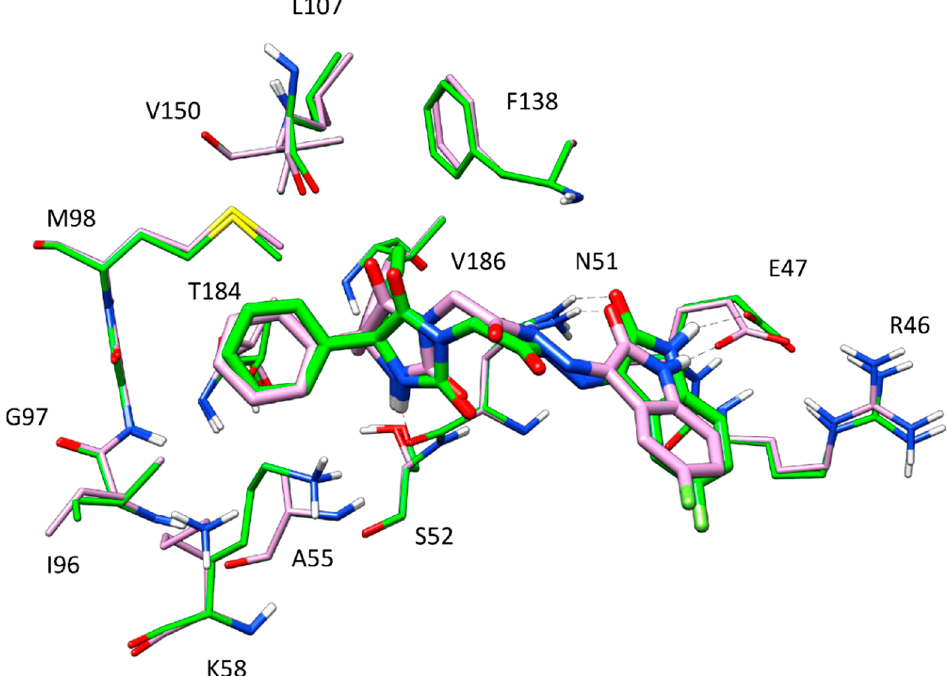
Figure 11. Superposition of the final frame of the elongated MD (shown in pink) with the predicted HAA 2021 -Hsp90 complex (shown in green).